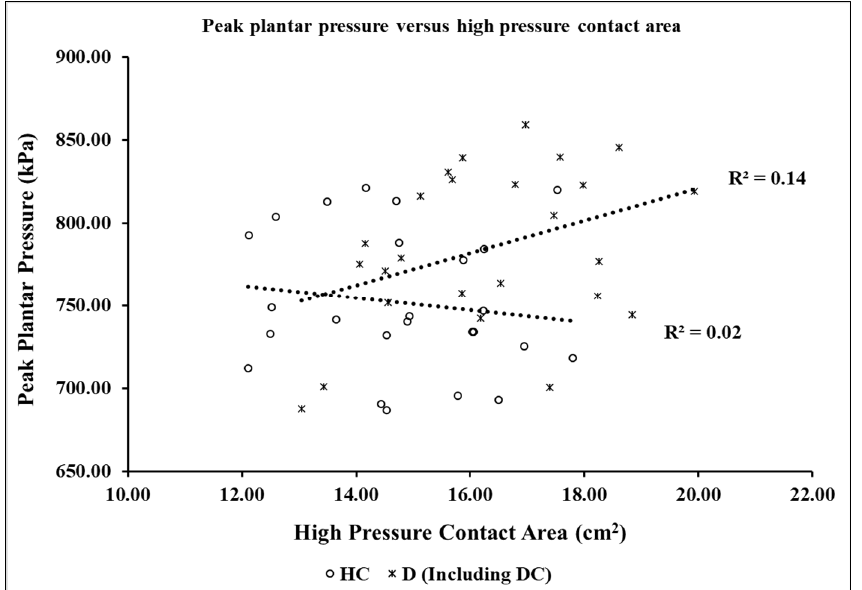
Figure 14. Correlation plot between the high-pressure contact areas and the peak plantar pressures across the HC and D (including the DC) volunteer groups, while walking.